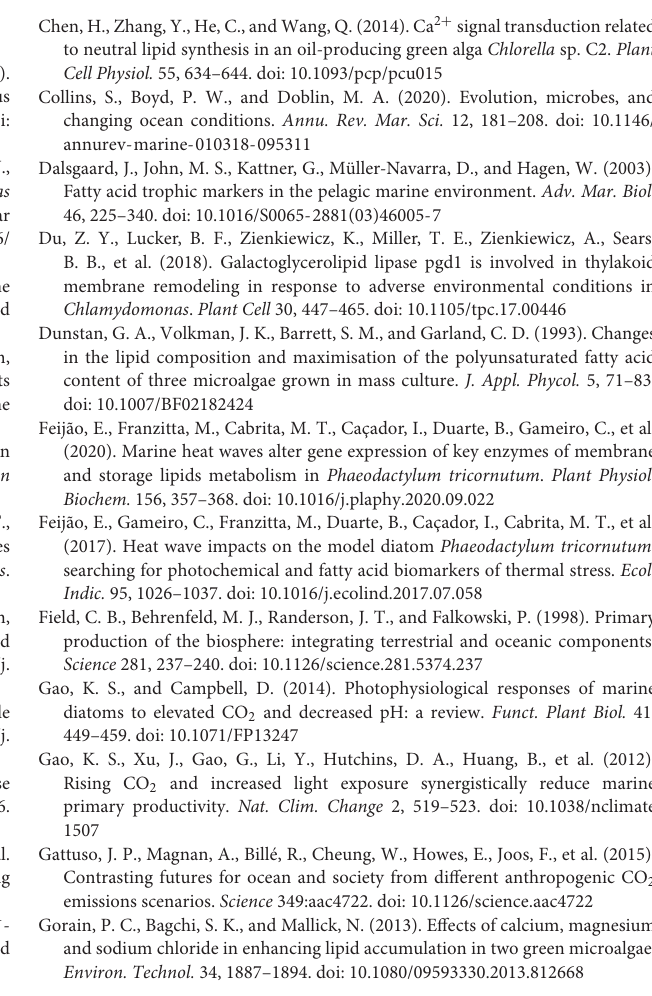
Supplementary Figure 1 | Pearson correlations between Quality control samples (QCs). Supplementary Figure 2 | The principal component analysis (PCA) of total lipid metabolites. Supplementary Figure 3 | Score plot from partial least squares discriminant analysis (PLS-DA) of the lipids in low (400 µ atm, LC) and high (1,000 µ atm, HC) CO 2 selected Phaeodactylum tricornutum cells. The PLS-DA showed a clear separation between the HC and LC selected cells with acceptable goodness of fit ( R 2 = 0.97) and predictive power ( Q 2 =